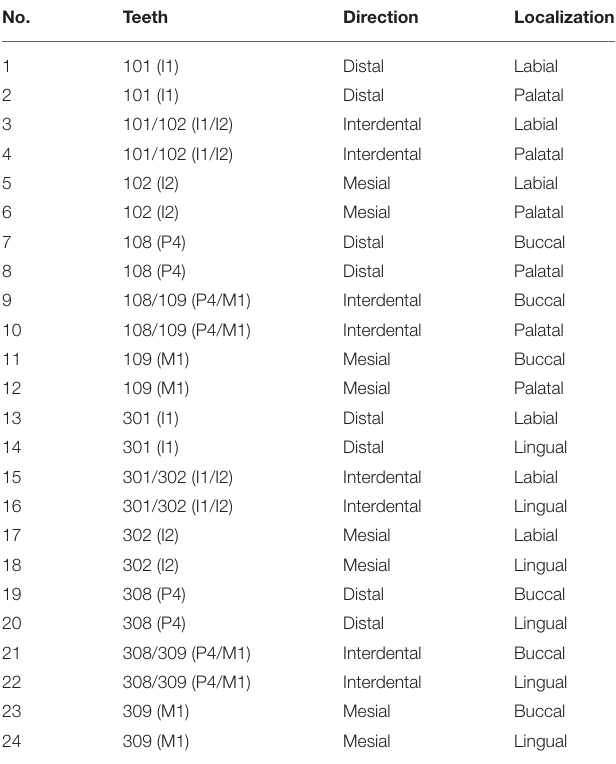
TABLE 2 | Preassigned locations of histologic specimen.